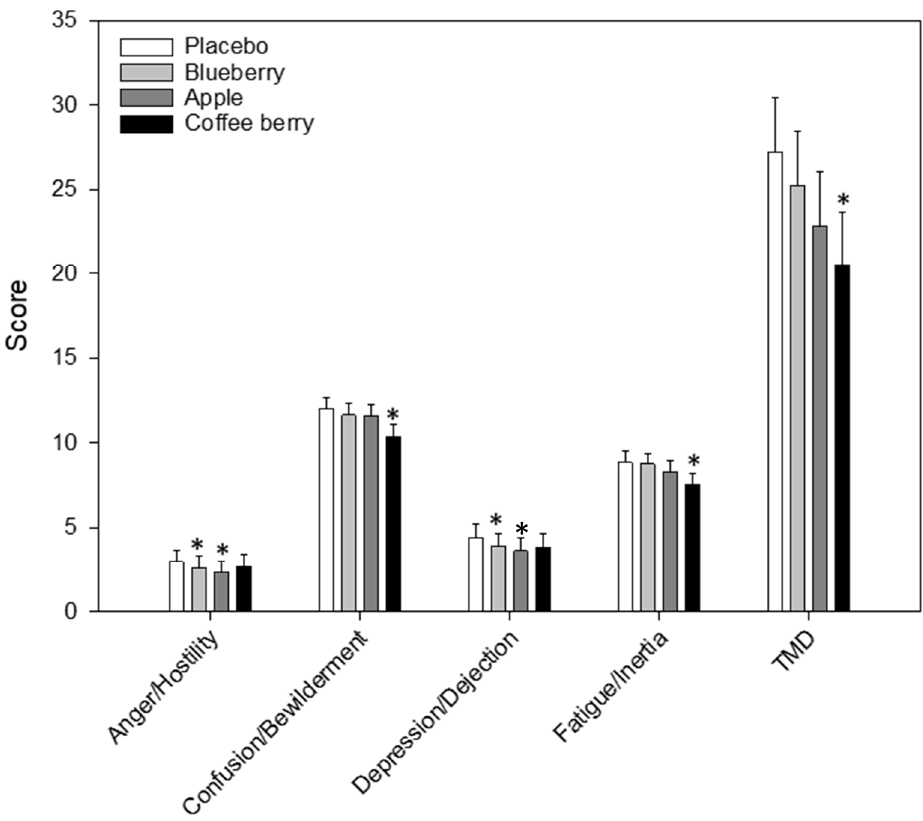
Figure 3. Profile of mood states. Values are adjusted means ± SEM derived from the linear mixed model using untransformed data ( n = 32). Treatment and time (60, 180, 360 min) and their interaction, i.e., treatment x time were entered into the model as fixed e ff ects. Respective pre-dose scores (baseline assessment) were also entered into the model as a covariate and subject was included as a random e ff ect. E ff ects were calculated using log-transformed data. Post-hoc comparisons were made between placebo and each of the active treatments using a Bonferroni adjustment for multiple comparisons. *, p < 0.05 (post-hoc test against placebo).